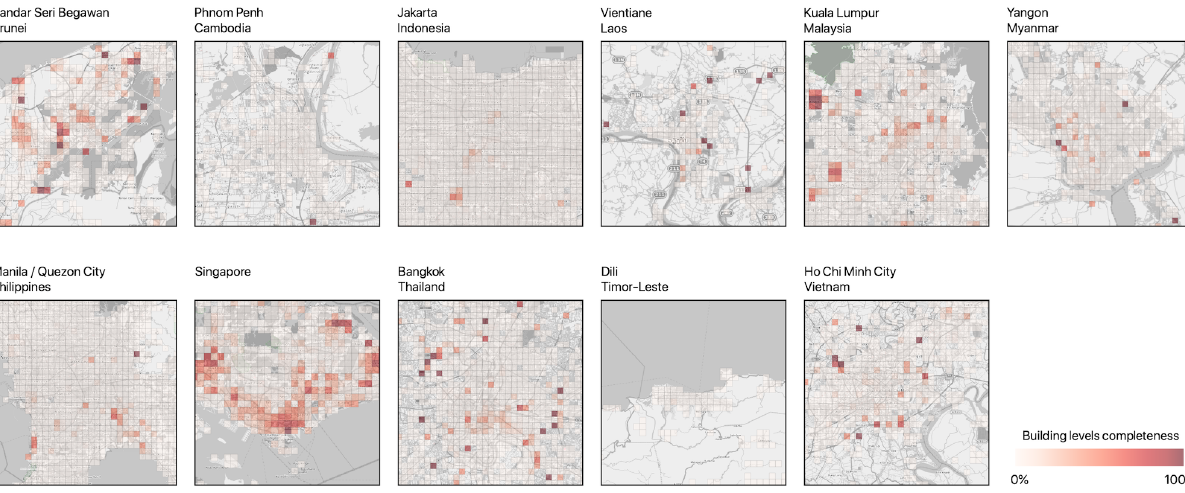
Figure 4. The completeness of building levels in the largest cities in the eleven countries. Each map shows an extent of approx. 25 x 25 km. (c) OpenStreetMap contributors.